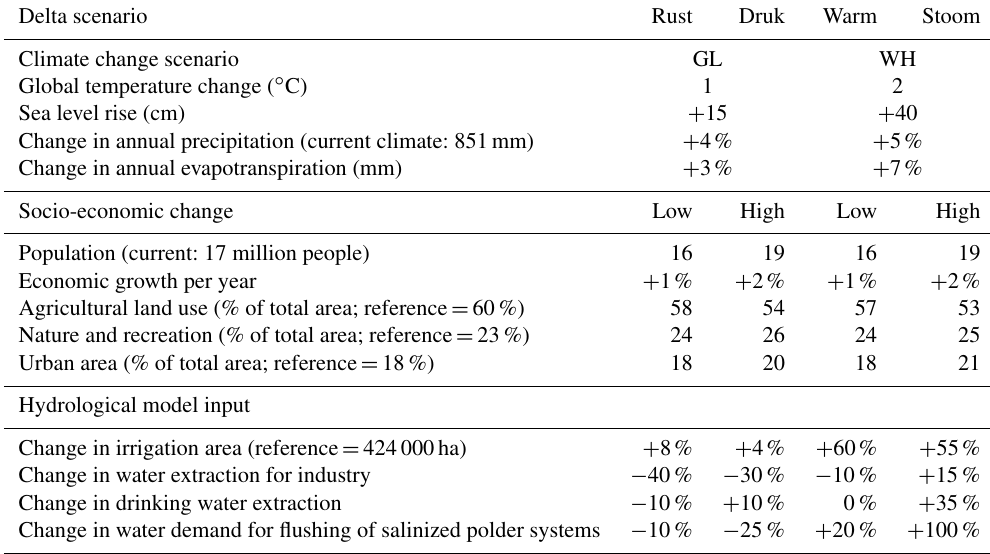
Table 1. Overview of scenario assumptions in the projections for 2050 (adapted from Wolters et al., 2018). Climate change is relative to the average climate over the period 1981–2010